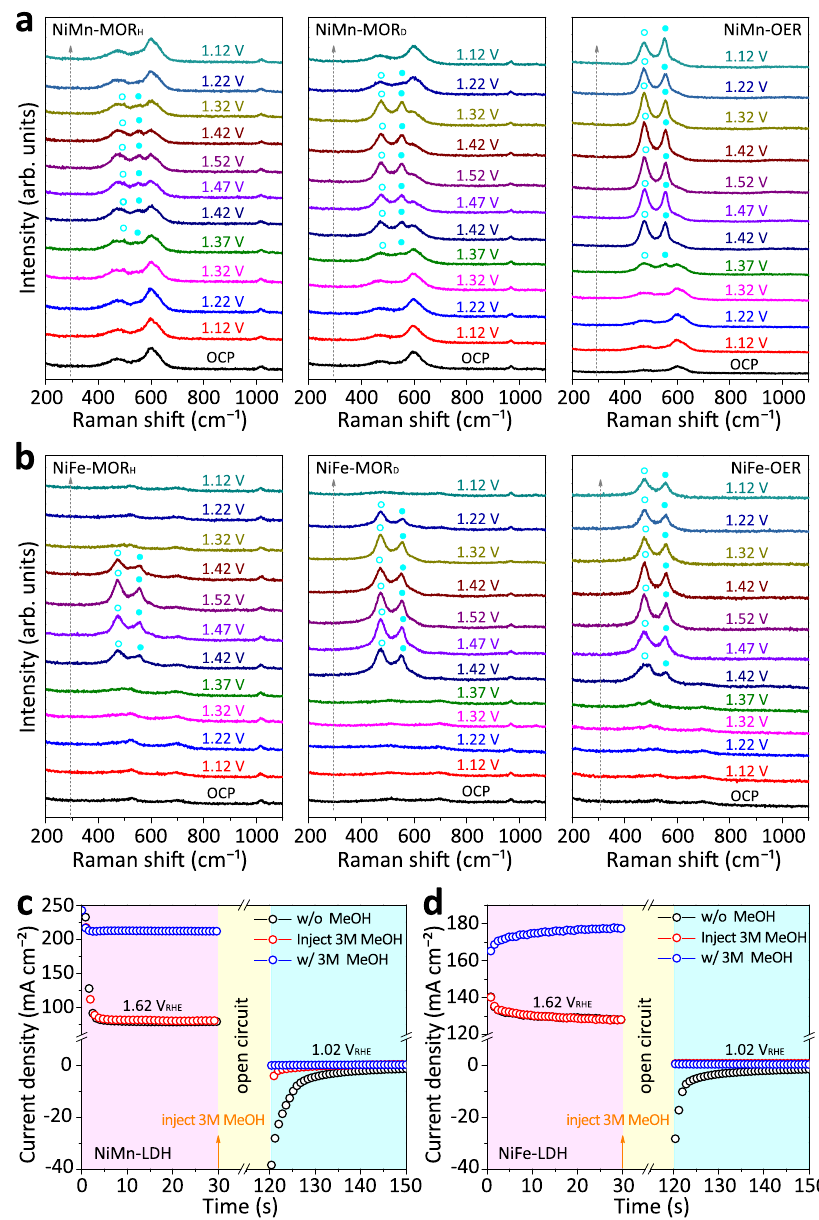
Fig. 3 | Evidence for in-situ formation and reduction of Ni III -OOH under the optimal MOR conditions. Operando Raman spectra of a NiMn and b NiFe-LDHs both obtained at various potentials under optimal MOR (the subscript H or D denotes CH 3 OH/H 2 O or CD 3 OD/D 2 O solution) and OER conditions, respectively. The blue circlesindicate the feature bands of Ni III -OOH.Multi-potentialstep